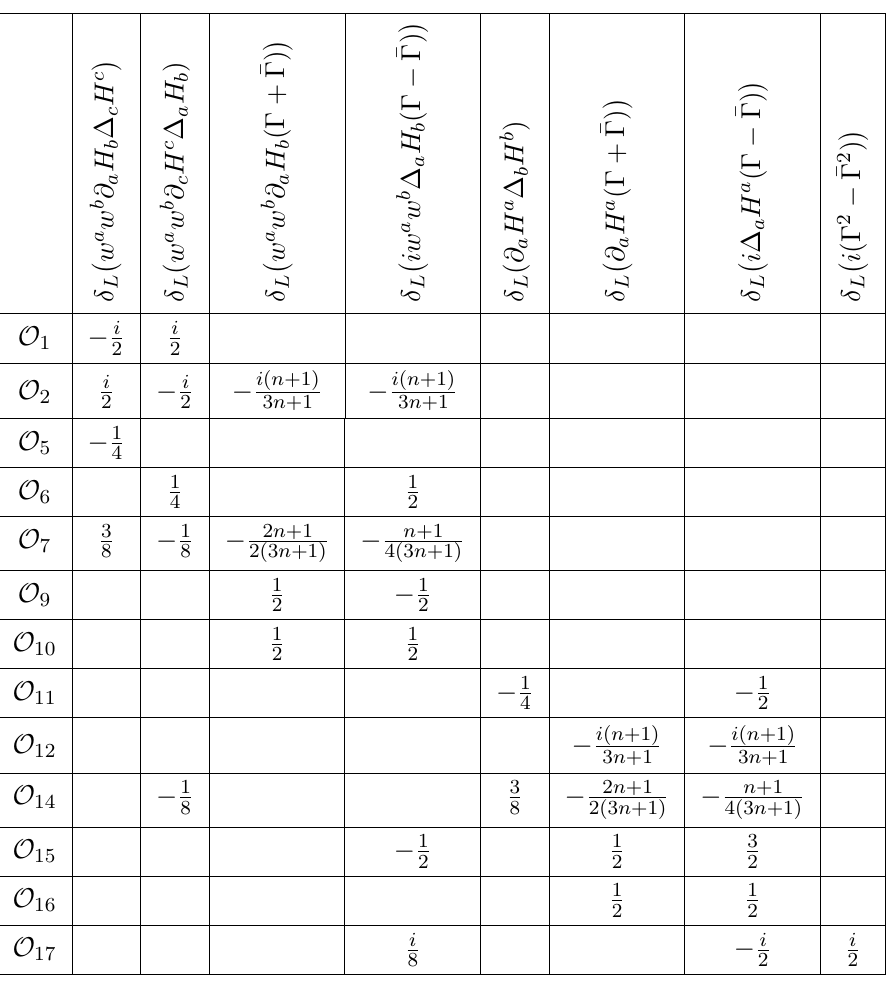
Table 2 . Same as table 1, but for the CP -odd